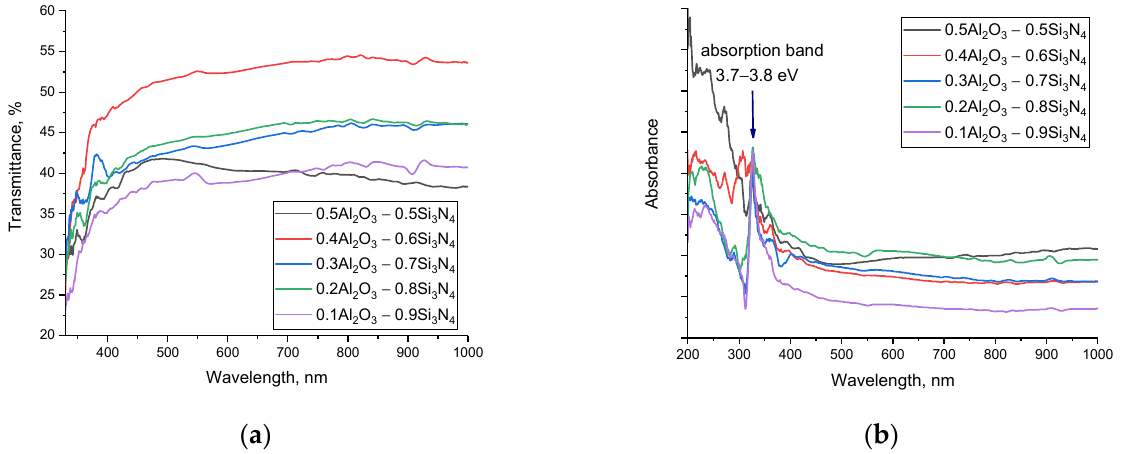
Figure 8. ( a ) Results of UV-Vis transmission spectra of (1 − x)Si 3 N 4 -xAl 2 O 3 ceramics versus compo- nent variation; ( b ) Results of UV-Vis absorption spectra of (1 − x)Si 3 N 4 -xAl 2 O 3 ceramics depending on component variation.